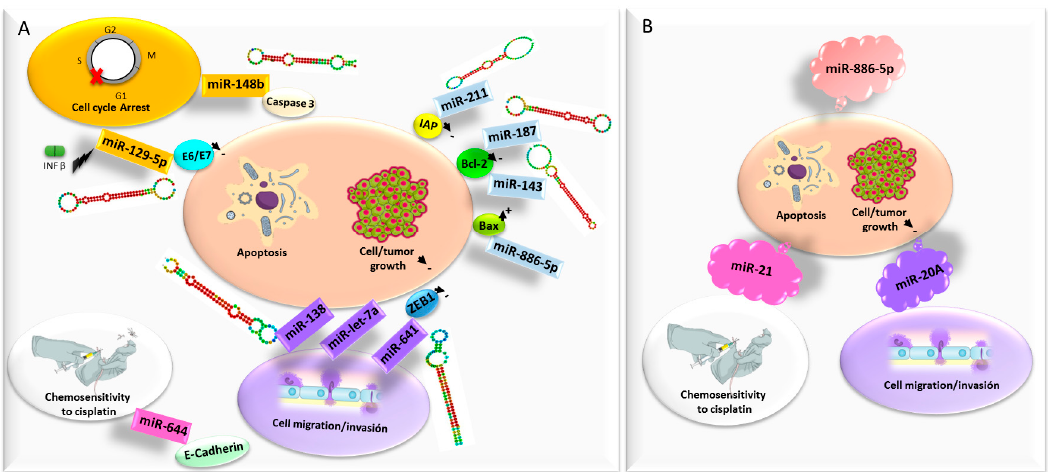
Figure 3. miRNAs as a therapeutic target against cervical cancer. Some miRNAs act as a tumor suppressor since they regulate oncogenes and are underexpressed in cervical cancer ( A ) while other miRNAs have an oncogenic capacity and are upregulated in cervical cancer cells ( B ). This feature makes them an attractive target for the treatment of cervical malignancies. miRNA images were obtained from Wikipedia.